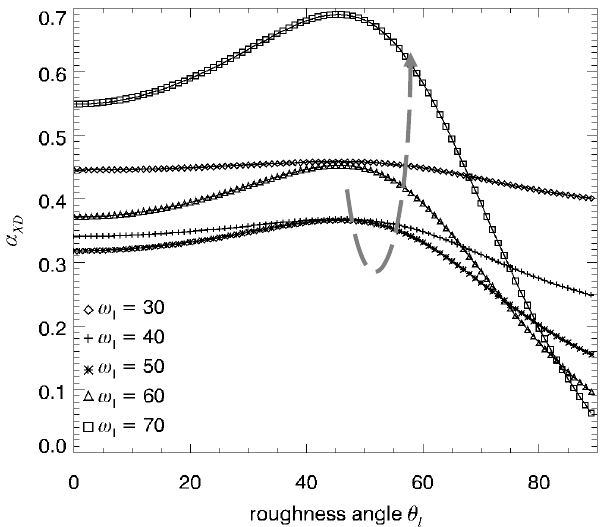
Figure 26. Sensitivity of α XD along the roughness angle θ 1 ; α XD is derived from the X-Fresnel scattering model ( ε s = 25, ε t = 15, ϕ = 0°) for different angles of local incidence ω l . Gray dashed arrow indicates dynamics with ω l .